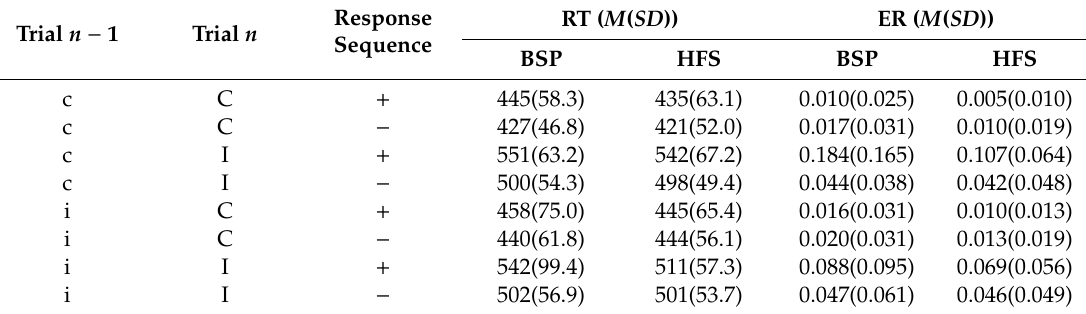
Table 3. Mean reaction times (RTs) and error rates (ERs) depending on trial